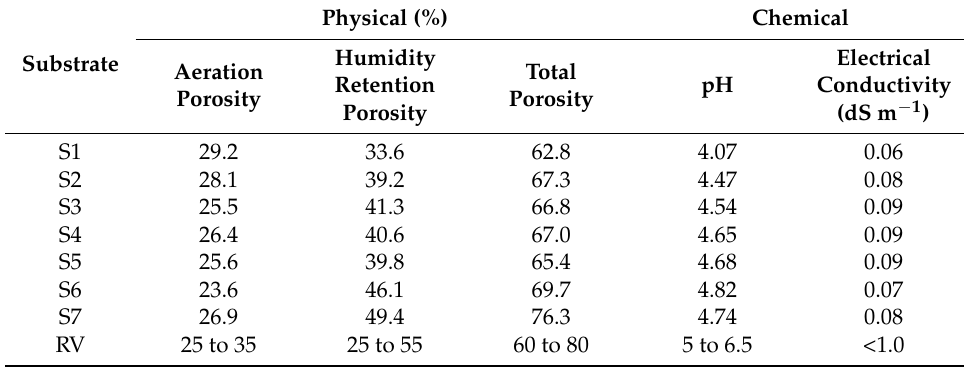
Table 2. Physical and chemical properties of the substrates evaluated in the production of Pinus engelmannii